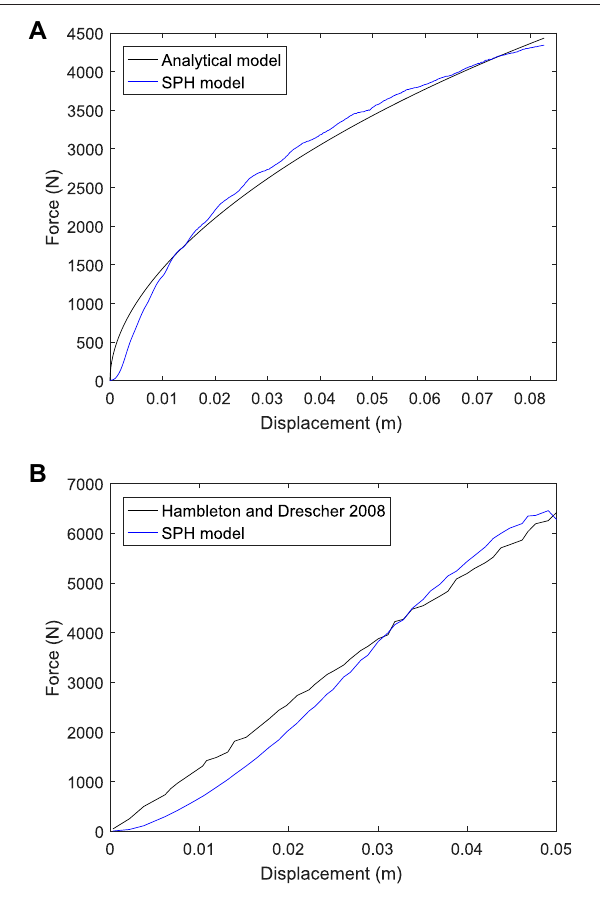
FIGURE 6 | Force-displacement results from simulations of wheel indentation into (A) a cohesive soil, and (B) a frictional soil from (Hambleton and Drescher, 2008) and for the current SPH